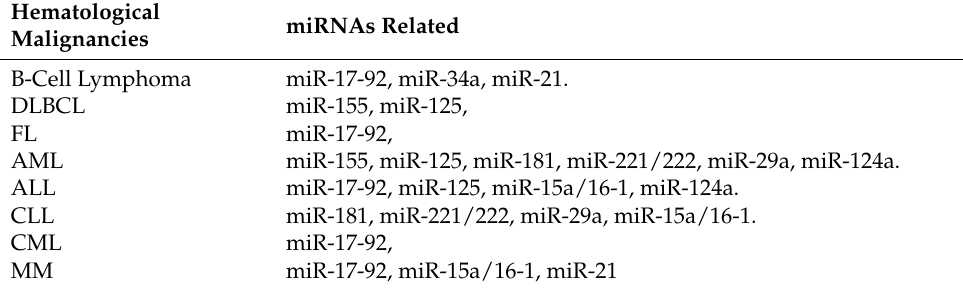
Table 2. MicroRNAs related to hematologic malignancies: DLBCL, diffuse large B-cell lymphoma; FL, follicular lymphoma; AML, acute myeloid leukemia; ALL, acute lymphocytic leukemia; CLL, chronic lymphocytic leukemia; CML, chronic myeloid leukemia; MM, multiple myeloma. Modified from Lawrie CH. MicroRNA in hematological malignancies [66].